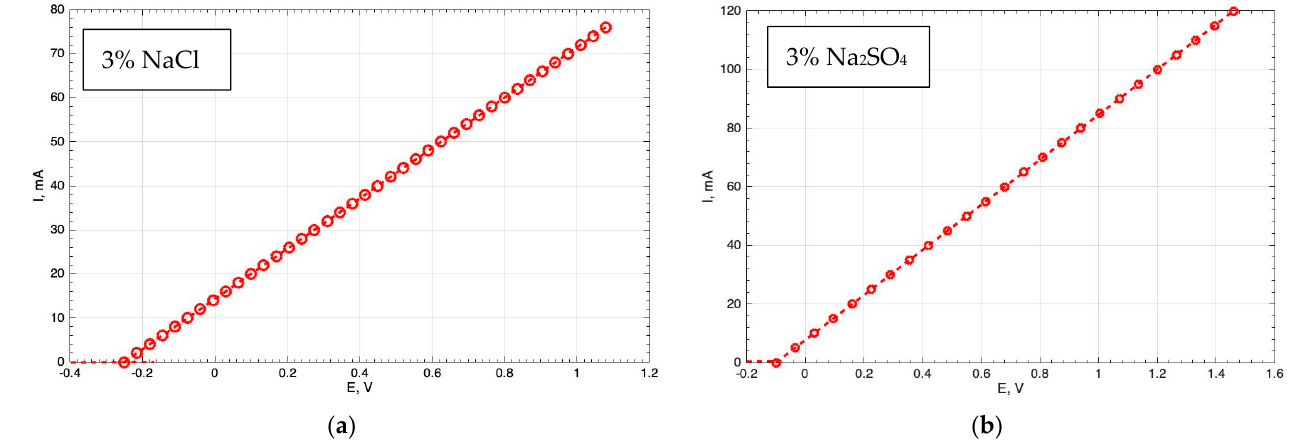
Figure 6. Potentiostatic polarisation curves on the untreated laser surface of steel in ( a ) 3% NaCl and ( b ) 3% Na 2 SO 4 .